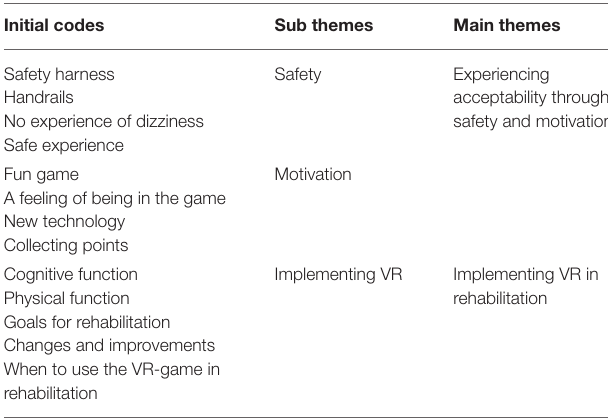
TABLE 1 | Coding process of the reflexive thematic